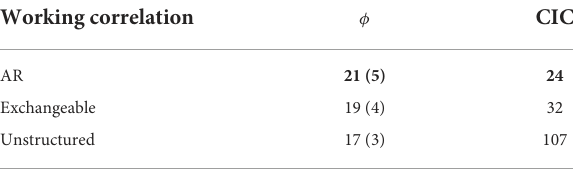
TABLE 2 Estimated GEE overdispersion ( φ ) with SE (standard error) according to the working correlation matrix. Working